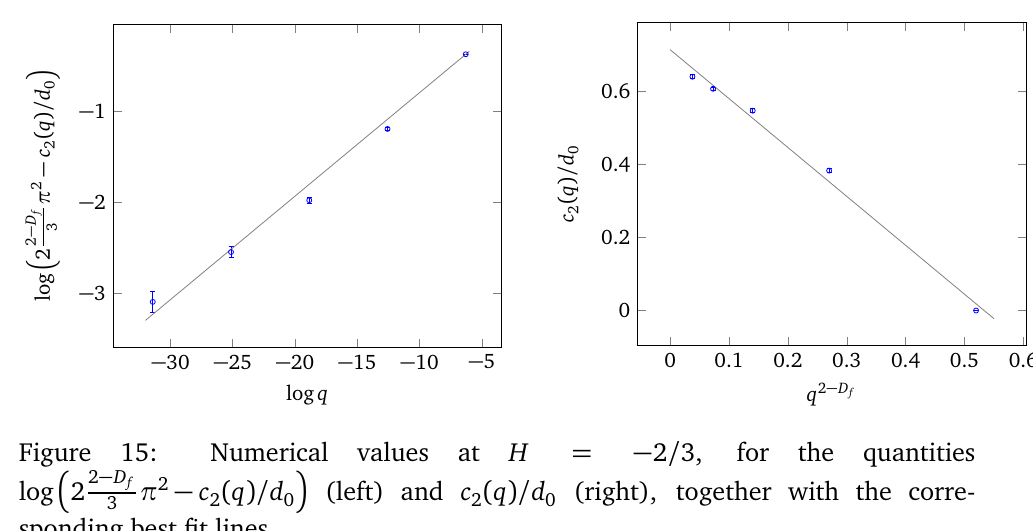
Figure 15: Numerical values at H = − 2 / 3, for the quantities